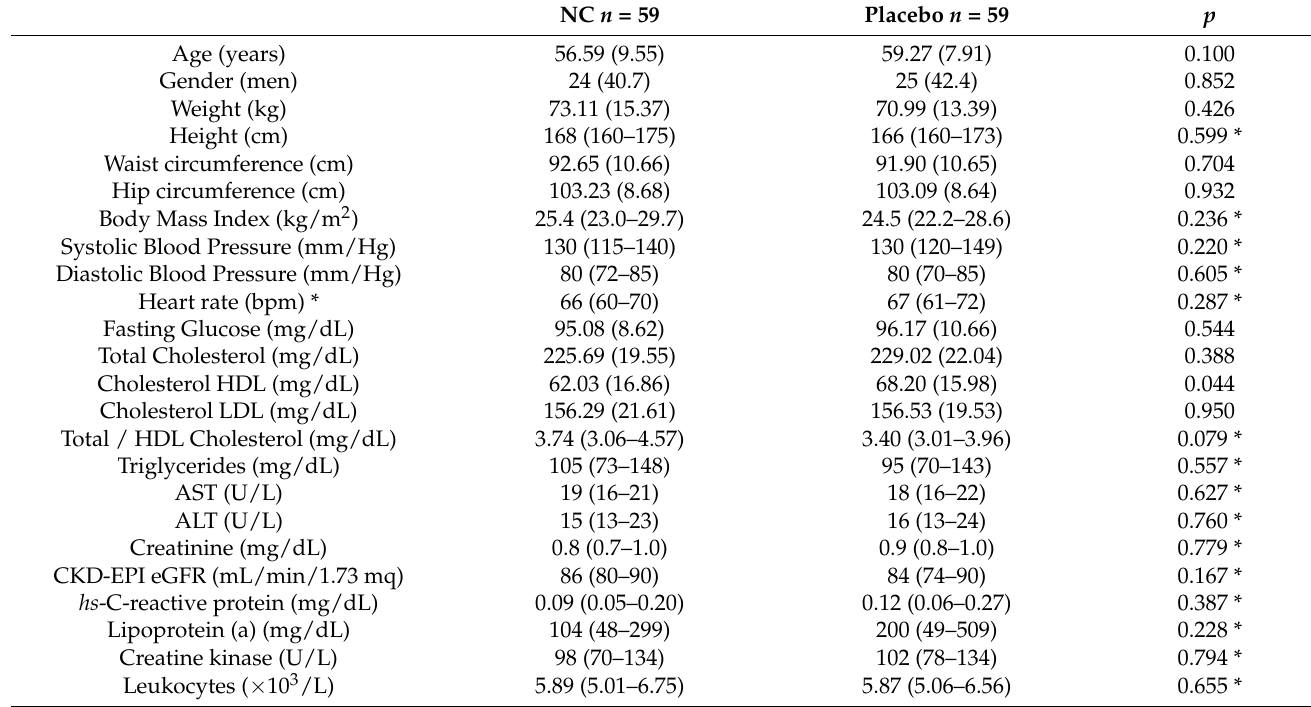
Table 1. Baseline clinical and biochemical characteristics of the enrolled subjects who completed the study by treatment group.